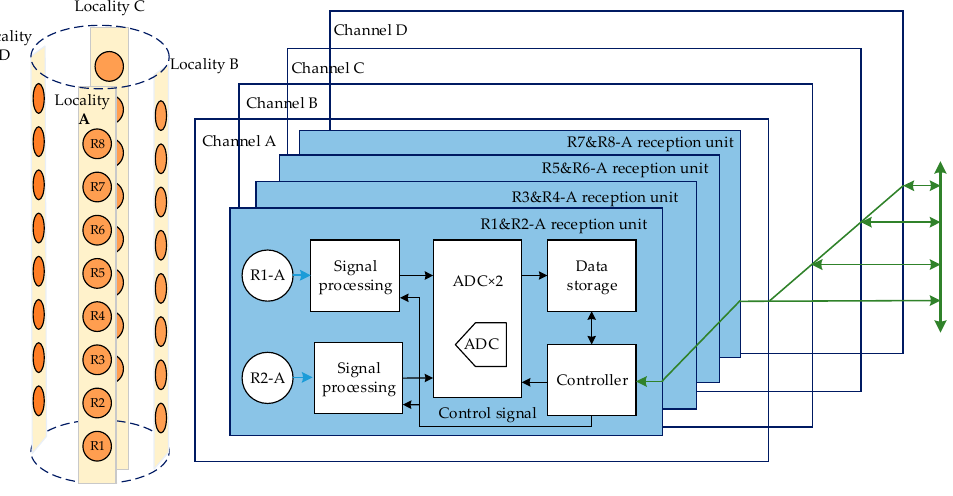
Figure 11. Schematic representation structure of reception system.